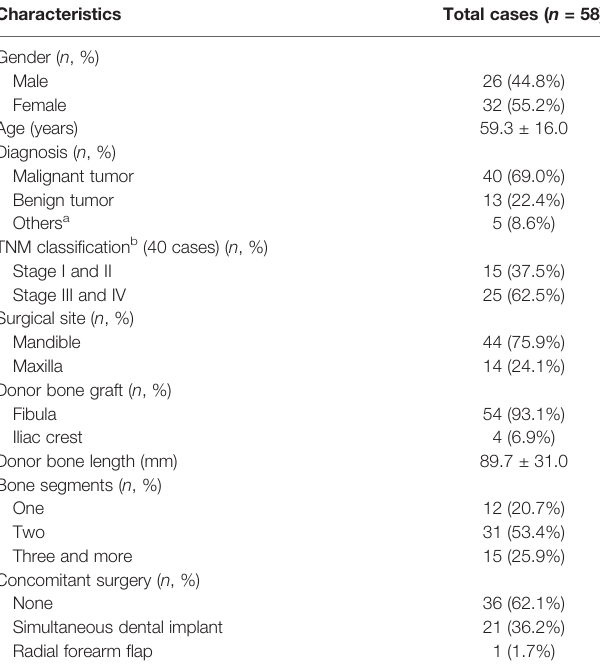
TABLE 2 | Baseline characteristics and surgical